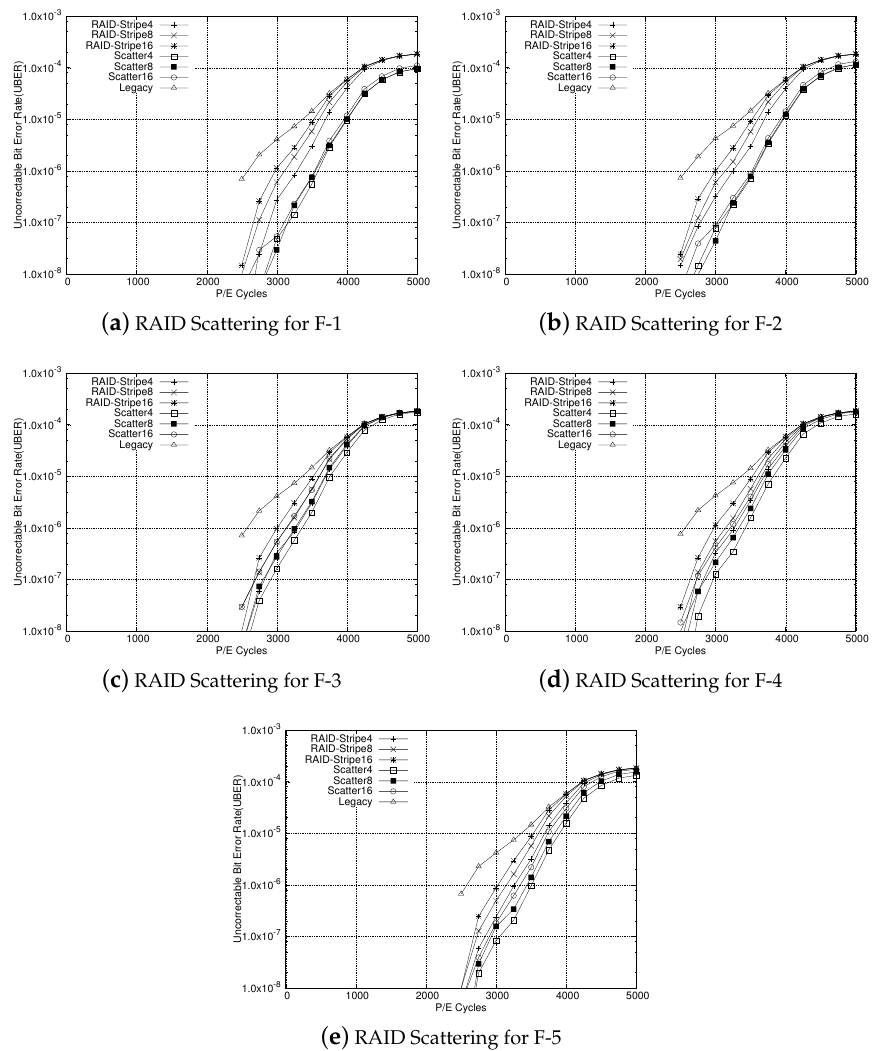
Figure 9. Experimental results for RAID scattering in comparison with original RAID with various stripe sizes. In accordance with P/E cycle, UBERs of RAID Scattering and original RAID are estimated along with stripe sizes four, eight, and 16.( a ) RAID Scattering for F-1, ( b ) RAID Scattering for F-2, ( c ) RAID Scattering for F-3, ( d ) RAID Scattering for F-4, ( e ) RAID Scattering for